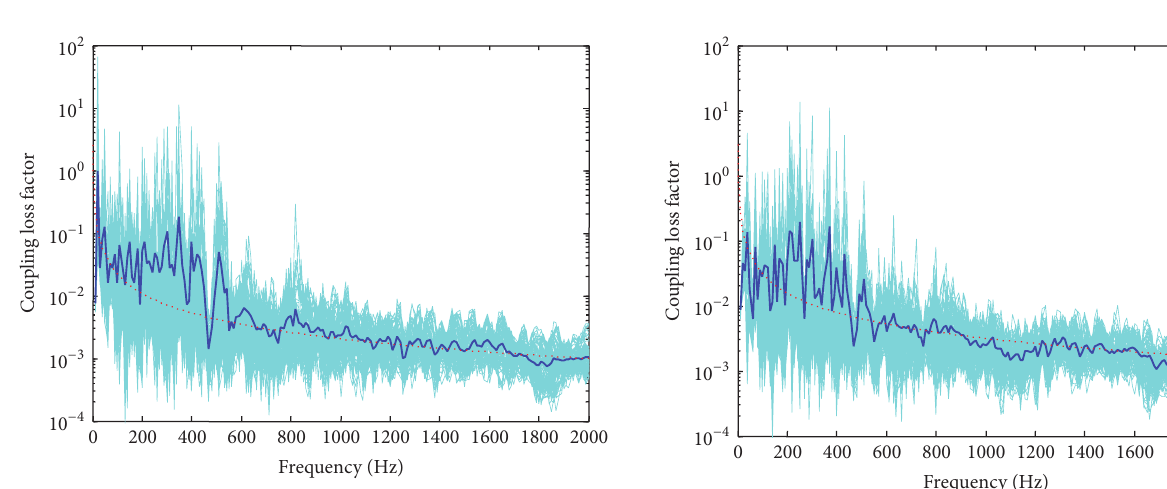
Figure 8: Comparison of 𝜂 12 when 𝑁 = 2 (narrowly-spaced): PIM simulations (real thin lines); ensemble average of the PIM solutions (thick real line); (43) (dotted line).